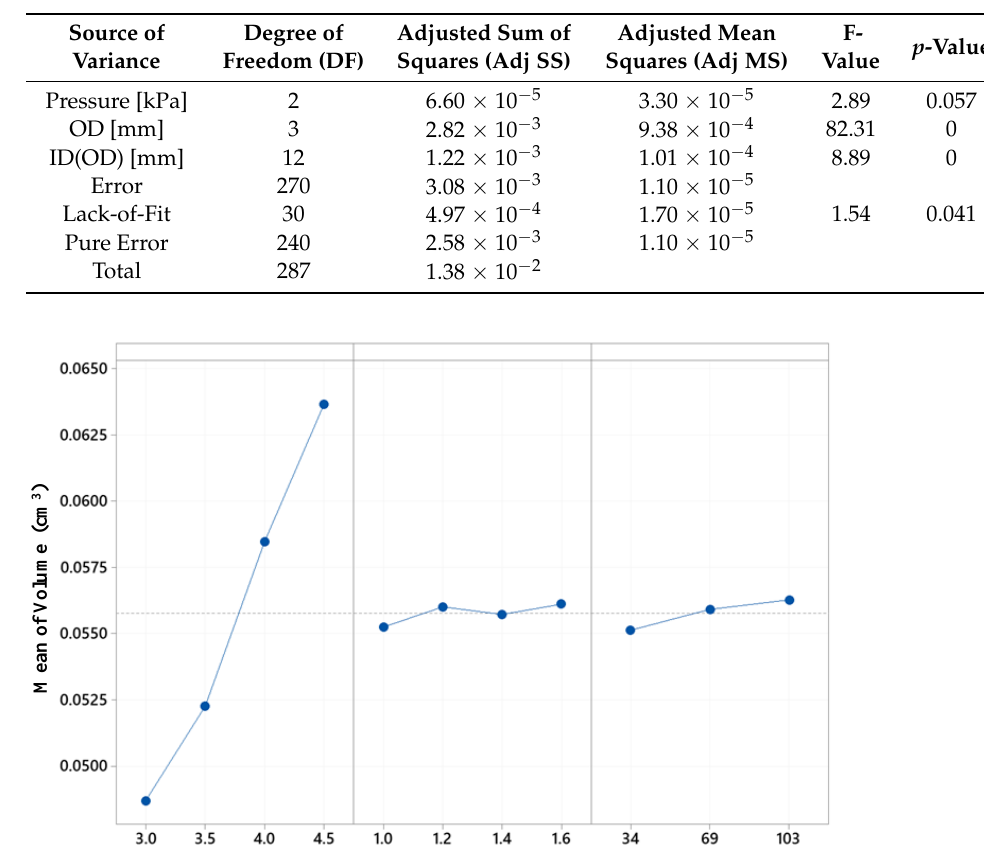
Figure 3. Mean of volume per drop related to the outside diameter, inner diameter, and pressure.